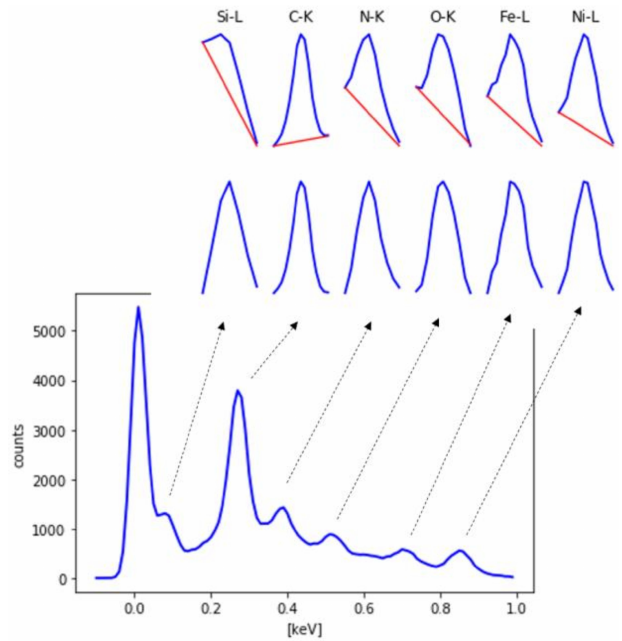
Figure 2. Example of a summed EDX spectrum for a single acquisition location, or map, and of peak post-processing output from a custom-made Python script that automatically extracts the data from the raw file and removes the background for Si–L, C–K, N–K, O–K, Fe–L, and Ni–L characteristic X-ray